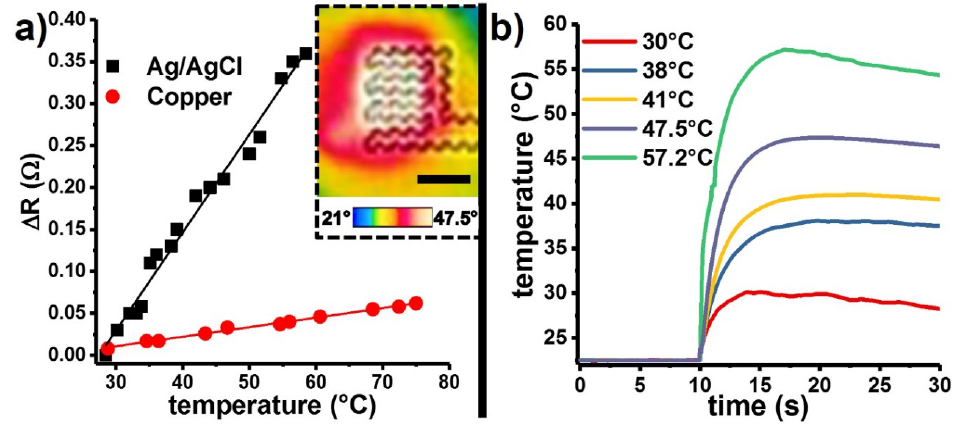
Figure 9. Sensing temperature using EPEDs: ( a ) Change of the EPED resistance as a function of temperature for EPEDs with a thin copper film (solid red dots) and Ag/AgCl ink (solid black squares) as conductive layers. The inset shows an IR image of an Ag/AgCl-based EPED when a small aluminum cylinder at 47.5 °C is placed on its surface for 10 s and then removed. Scale bar is 5 mm; ( b ) Response of the Ag/AgCl-based EPED thermometers when an aluminum cylinder at different temperatures is placed in contact with the EPED at t = 10 s.